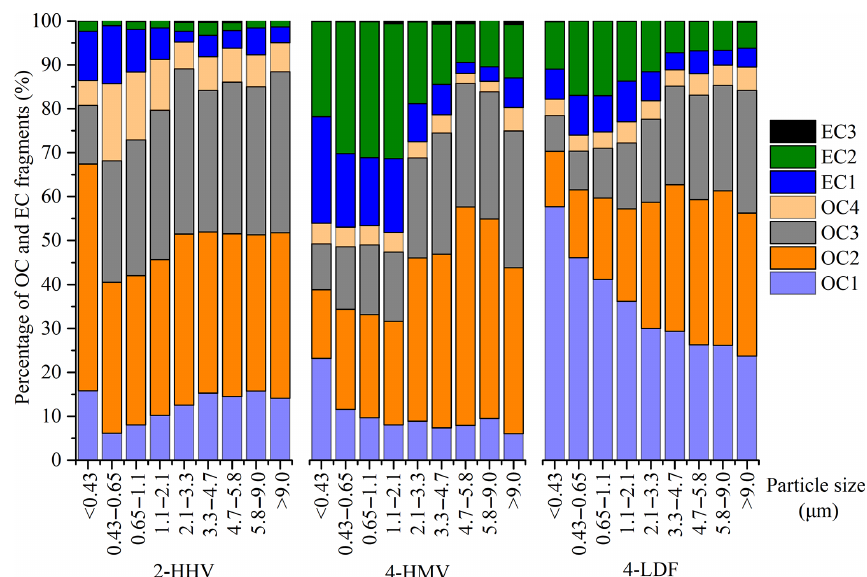
Figure 5. Percentage of OC and EC fragments in different particle-size